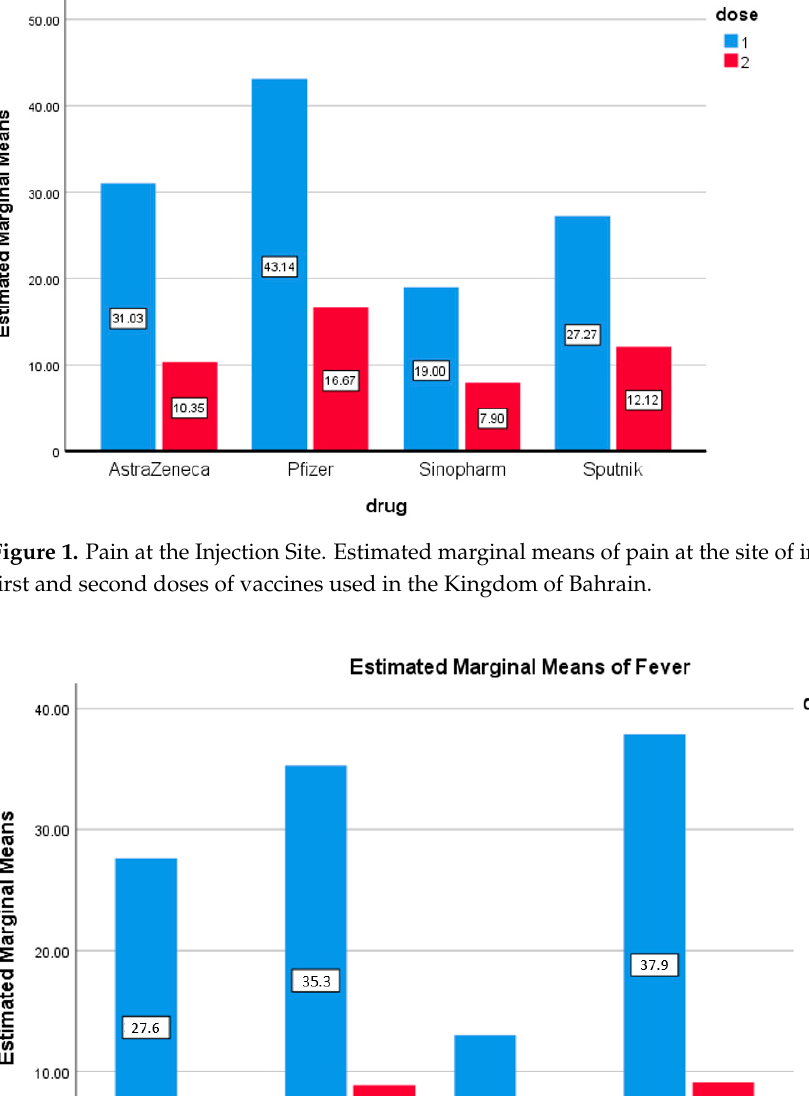
Figure 2. Fever. Estimated marginal means of fever after first and second doses of vaccines used in the Kingdom of Bahrain.